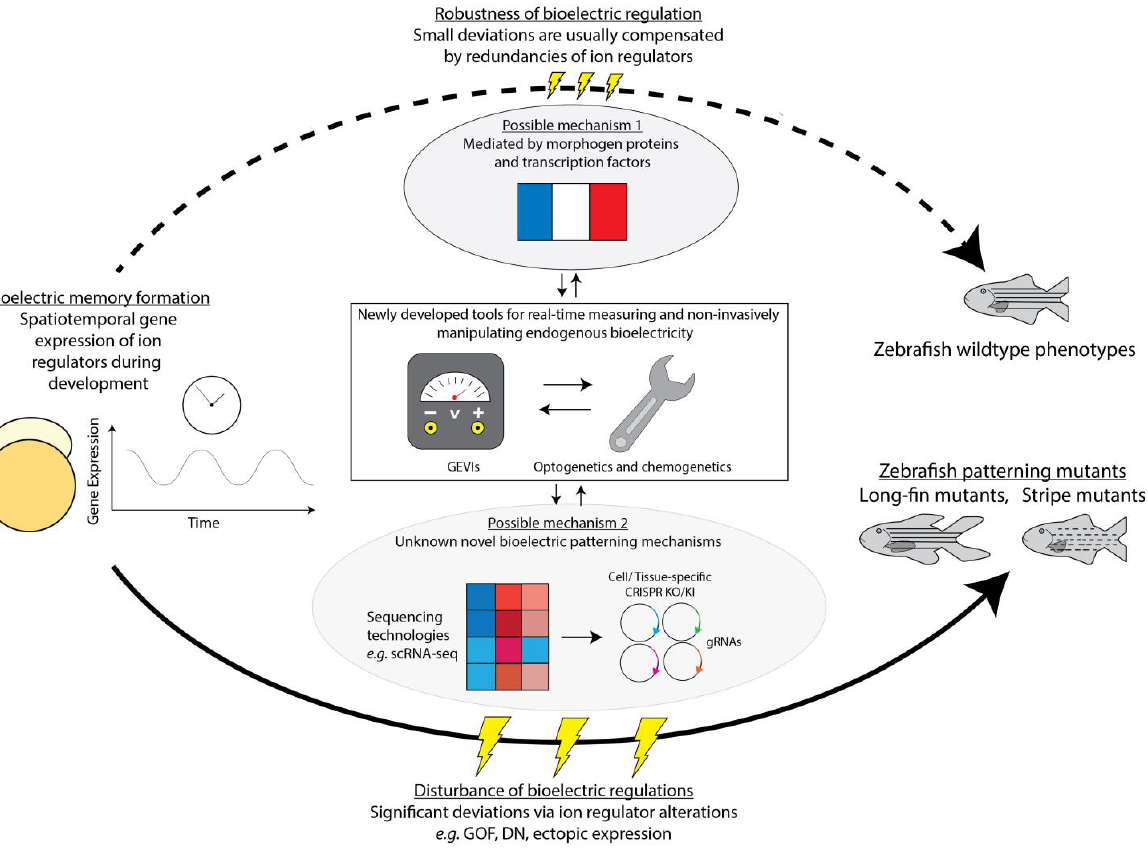
Figure 3. Summary and perspectives of bioelectricity in zebrafish developmental patterning research. Bioelectricity may function in zebrafish early embryos for patterning adult tissue/organs. Multiple ion regulators exist in each cell, so the cell’s bioelectric properties are generally robust. Minor disruptions (smaller lightning arrows) are not enough to change the bioelectric status quo, and only significant changes (big lightning arrows) may break through the robustness. This may explain why most zebrafish mutants were found with GOF (gain-of-function), DN (dominant negative), and ectopic expressions. Mechanistically, this bioelectric patterning may interact with already-known morphogen proteins and transcription factors. However, most likely, there are unknown mechanisms that mediate this bioelectric patterning. Next-generation sequencing technologies and CRISPR genome editing may help decipher such novel mechanisms. In addition, the recently developed genetically encoded tools for neuroscience, such as GEVIs, optogenetics, and chemogenetics, are readily adopted to the embryonic patterning research field. These tools allow us to monitor and manipulate bioelectricity in a non-invasive